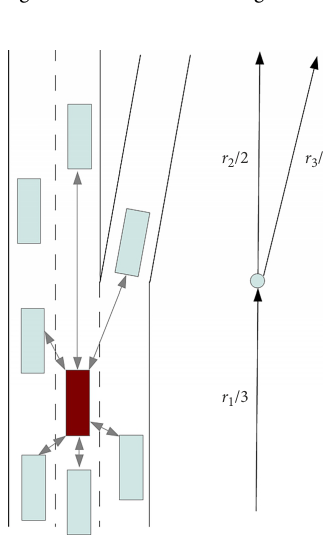
Figure 8. Definition of lane geometry